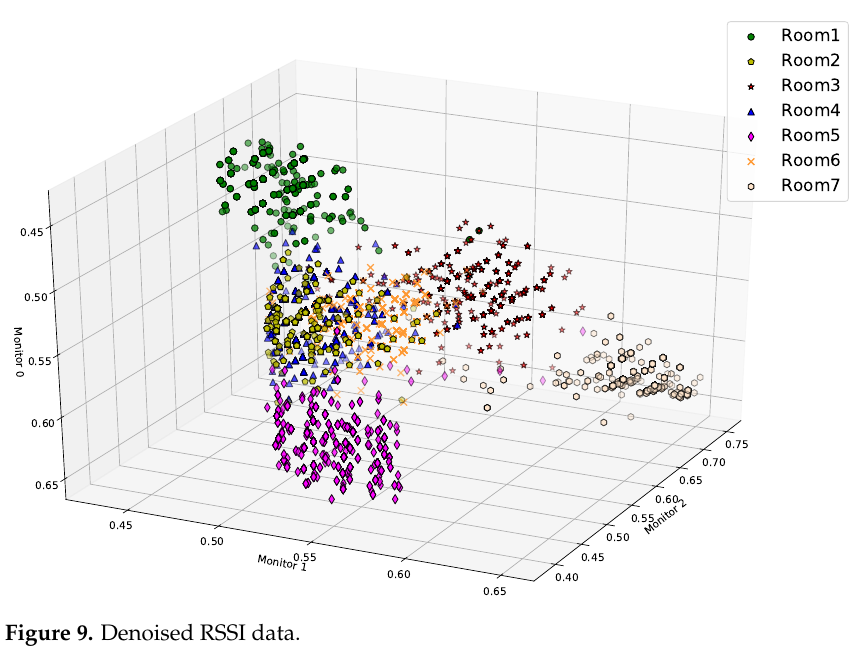
Figure 9. Denoised RSSI